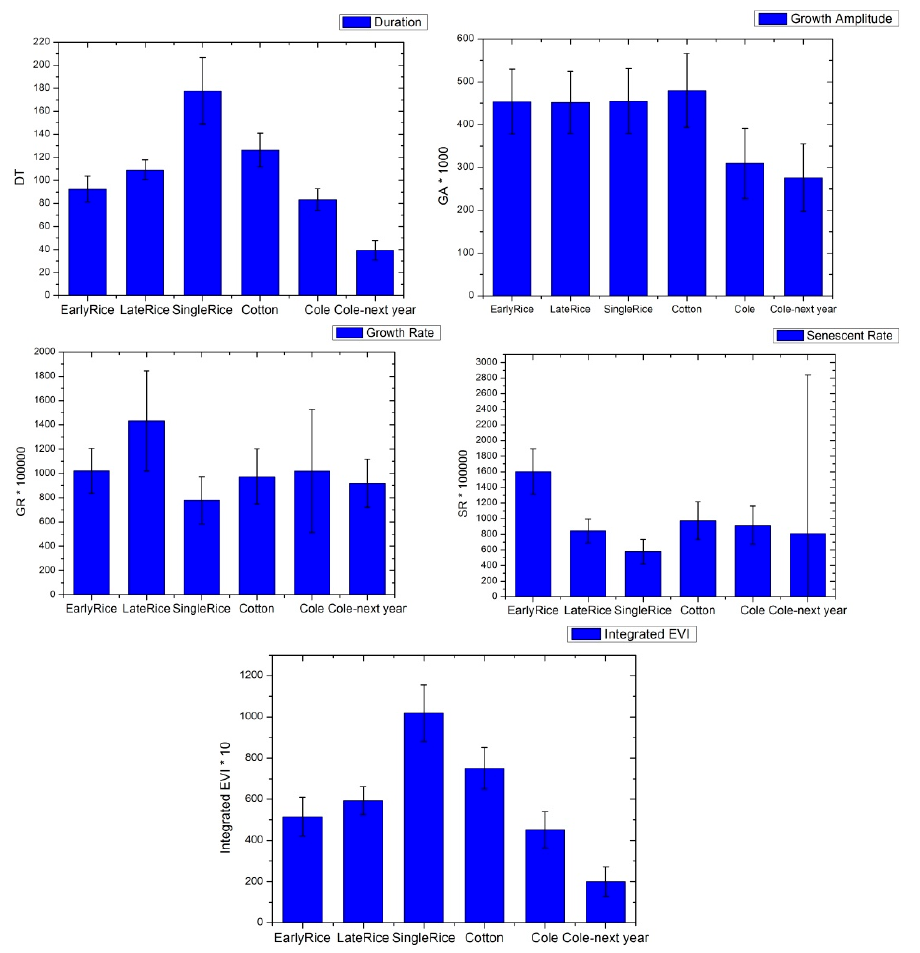
Figure 10. Phenological statistics (‘cole’ represents the cole sown in autumn of the previous year, and ‘cole-next year’ represents cole that was transplanted in one year and is to be harvested in the next